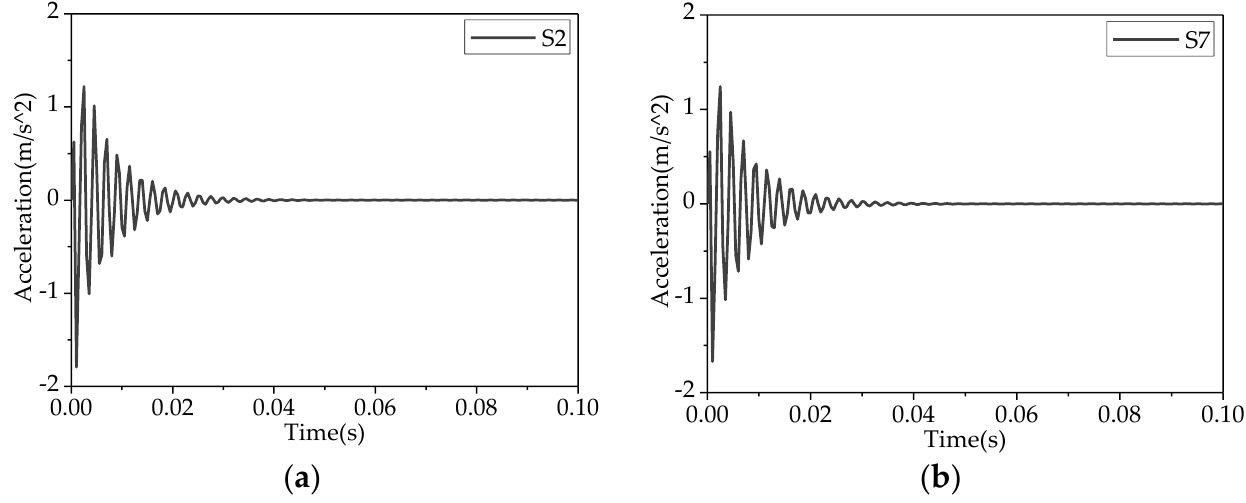
Figure 14. ( a ) Acceleration signals of S2. ( b ) Acceleration signals of S7.